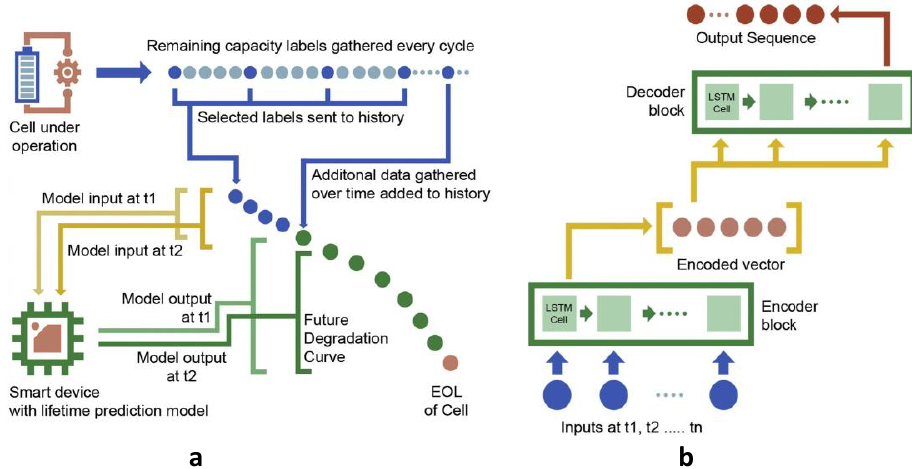
Figure 8. ( a ) Choice of input to the model and the approach of increasing the input window with time. ( b ) The general architecture of the sequence-to-sequence neural network. Reprinted from Ref. [101].